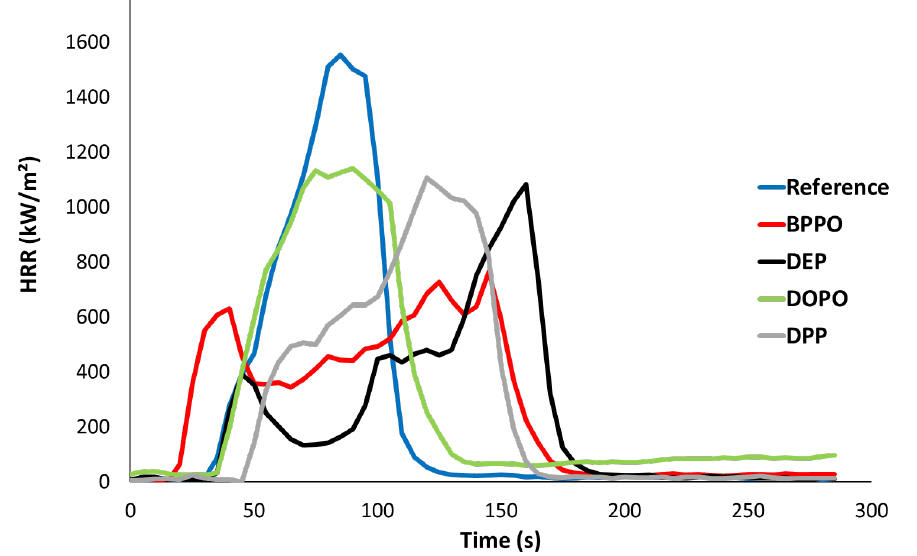
Figure 5. HRR curves in cone calorimeter for reference and PHUs containing 2 wt% of phosphorus. Reference ignites at 36 s and vigorous bubbling is observed at the sample